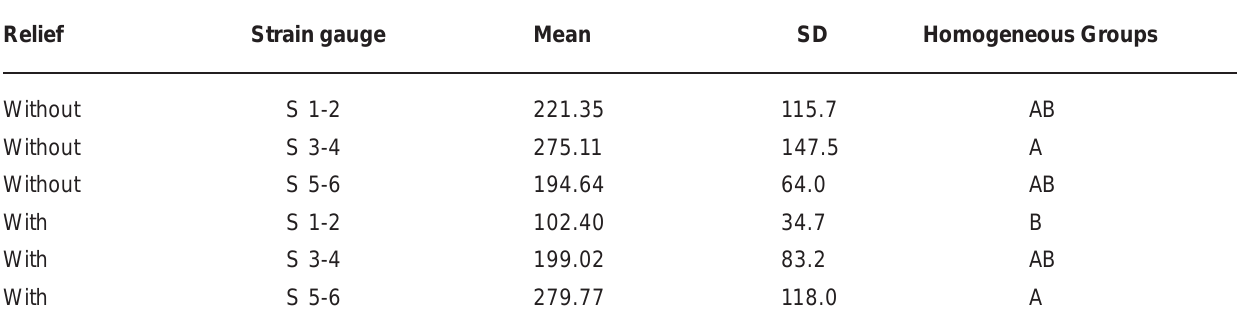
TABLE 2- Homogeneous groups established by Tukey’s test (5%) for the experimental